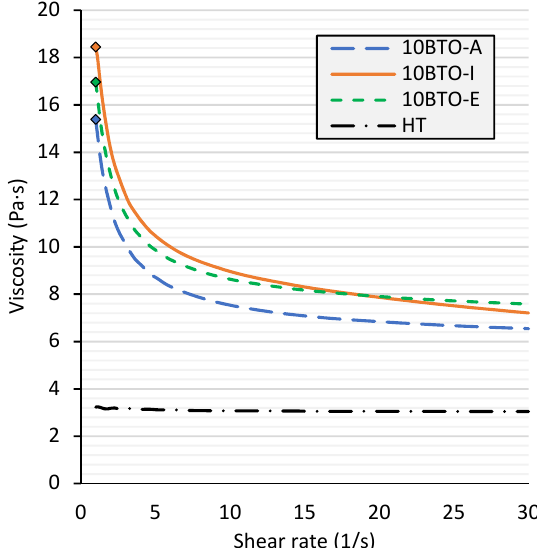
Figure 3. Viscosity values of 10 vol.% BTO/photopolymer suspensions dispersed with different solvents.